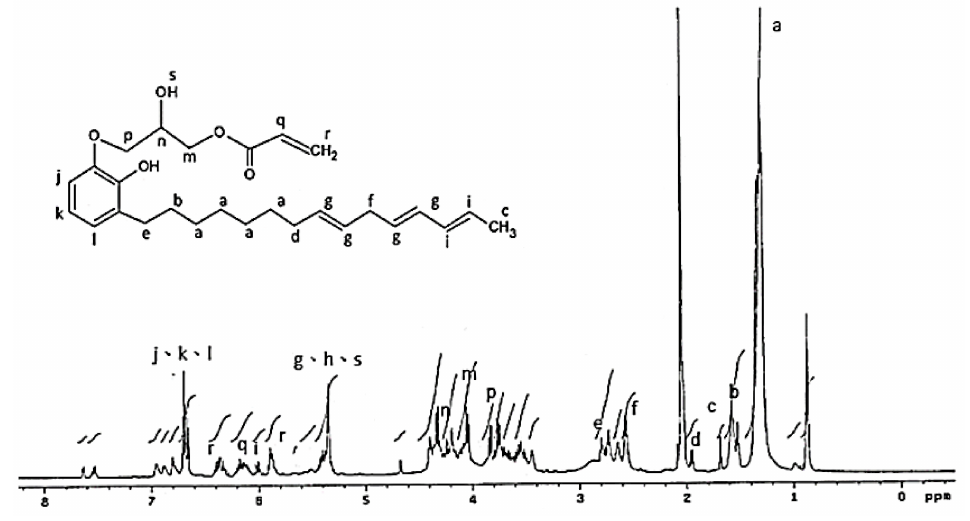
Figure 4. 1 H NMR spectrum of